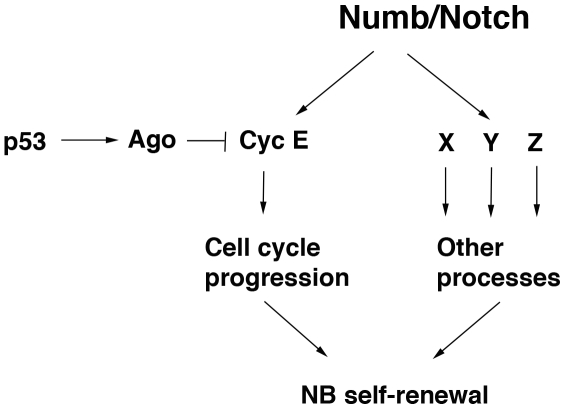
A diagram depicting the roles of Cyc E and other yet to be identified factors involved in the ectopic neuroblast formation process.A number of cellular processes such as cell cycle progression regulated by Cyc E and other processes mediated by unknown factors X, Y, Z are proposed to act coordinately to promote the self-renewal of normal or cancer stem cells. Interruption of any one of these processes, as in the case of inhibition of Cyc E expression through Ago by p53, will disrupt the self-renewal process. On the other hand, to promote ectopic neuroblast self-renewal, Cyc E and the other factors (X, Y, Z) would all have to be upregulated in a coordinated fashion. Activation of Cyc E alone will not be sufficient.